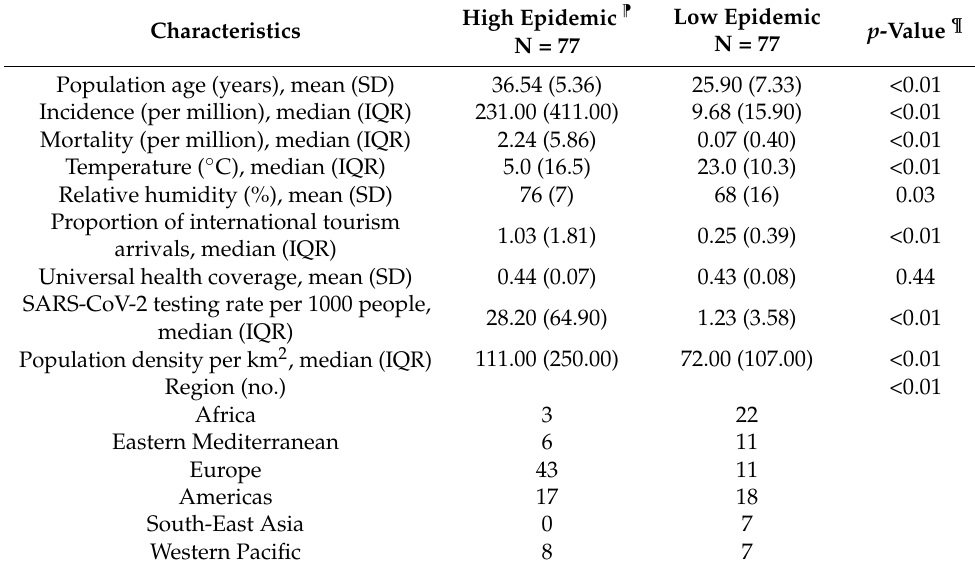
Figure 1. Scatterplot showing the relationship between average annual temperature (°C) and ( a ) incidence (per million) and ( b ) mortality (per million) of SARS-CoV-2. Table 1. Characteristics by the epidemic status of the study countries.